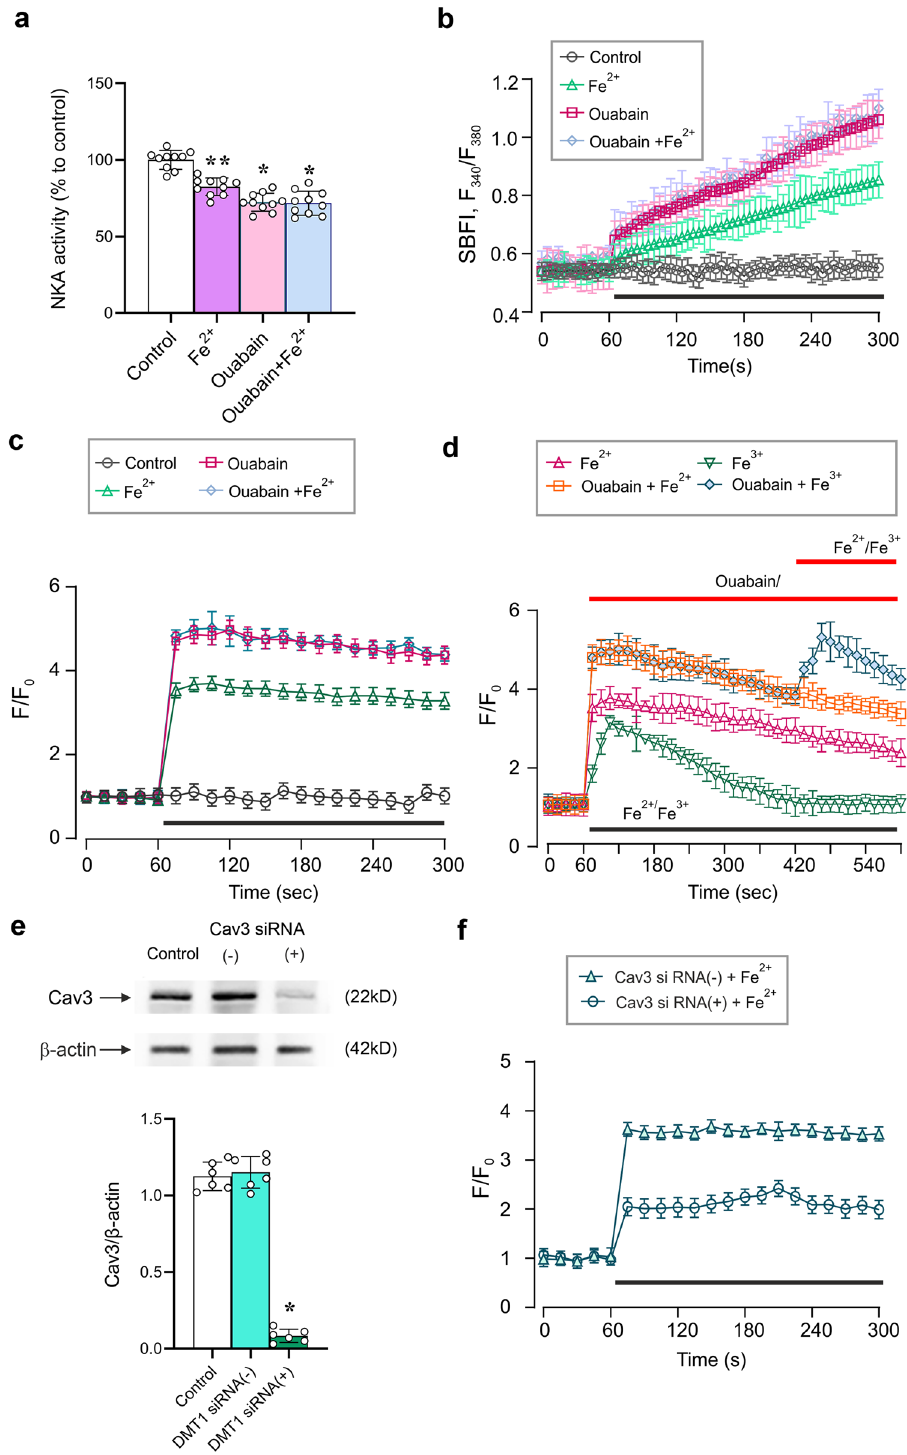
Fig. 4 Fe 2 + reverses NCXs by inhibiting NKA. a NKA activity in the presence of Fe 2 + and ouabain measured by ELISA; OD value was normalised to controls. Data represent mean ± SD, n = 10. *Indicates statistically signi fi cant ( p < 0.05) difference from control group; **indicates statistically signi fi cant (p < 0.05) difference from any other group. b [Na + ] i recordings from cultured astrocytes challenged with Fe 2 + and ouabain as indicated on the graph ( c ) and ( d ) [Ca 2 + ] i recordings from cultured astrocytes challenged with Fe 2 + , Fe 3 + and ouabain as indicated on the graph. For b, c and d every data point represents mean ± SD, n = 10. e Representative west e rn blot bands for Cav3 in cultured astrocytes treated with sham (Control), siRNA negative control ( − ), or positive duplex chains ( + ) to down-regulate Cav3 expression. Protein values are shown as the ratio of Cav3 (22 kDa) to β -actin (42 kDa). Data represent mean ± SD, n = 6. *Indicates statistically signi fi cant ( p < 0.05) difference from any other group. f Cav3 RNA interference suppresses Fe 2 + -induced [Ca 2 + ] i response. Every data point represents mean ± SD, n =